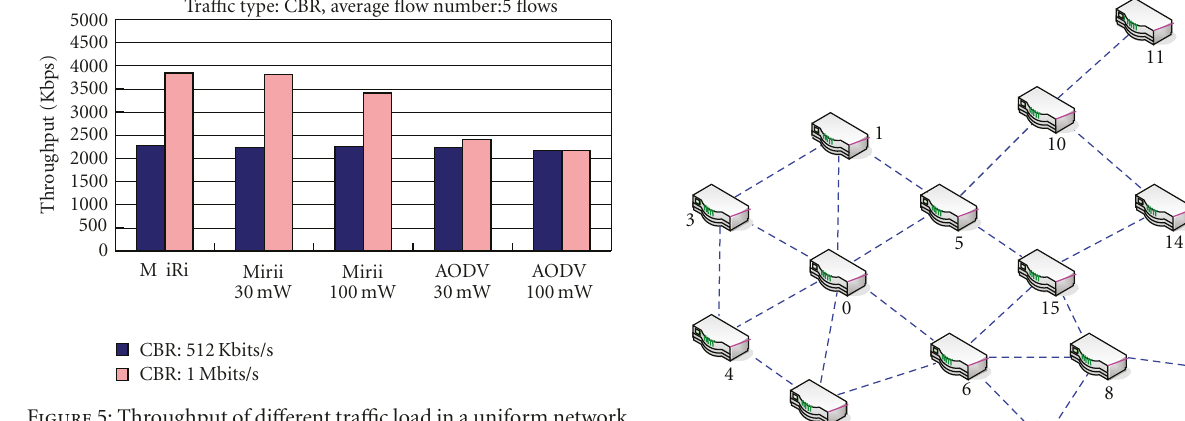
Figure 5: Throughput of di ff erent tra ffi c load in a uniform network topology.